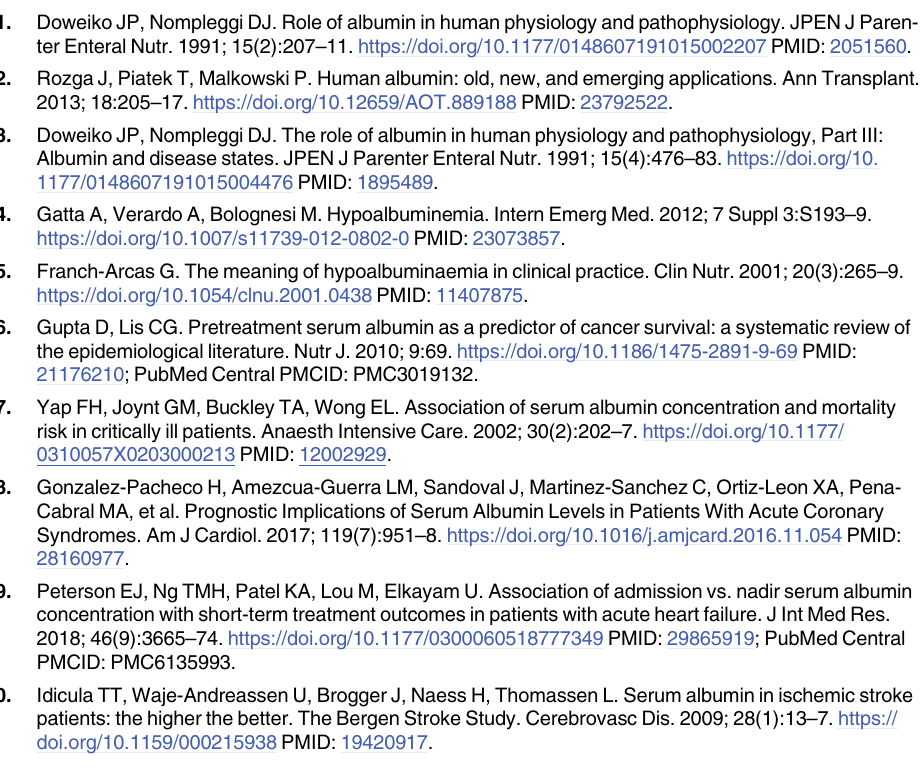
S2 Table. Unadjusted correlation between serum albumin and sickle cell clinical variables in adults with sickle cell disease in validation cohort (OMG). Results are in median (IQR) unless otherwise